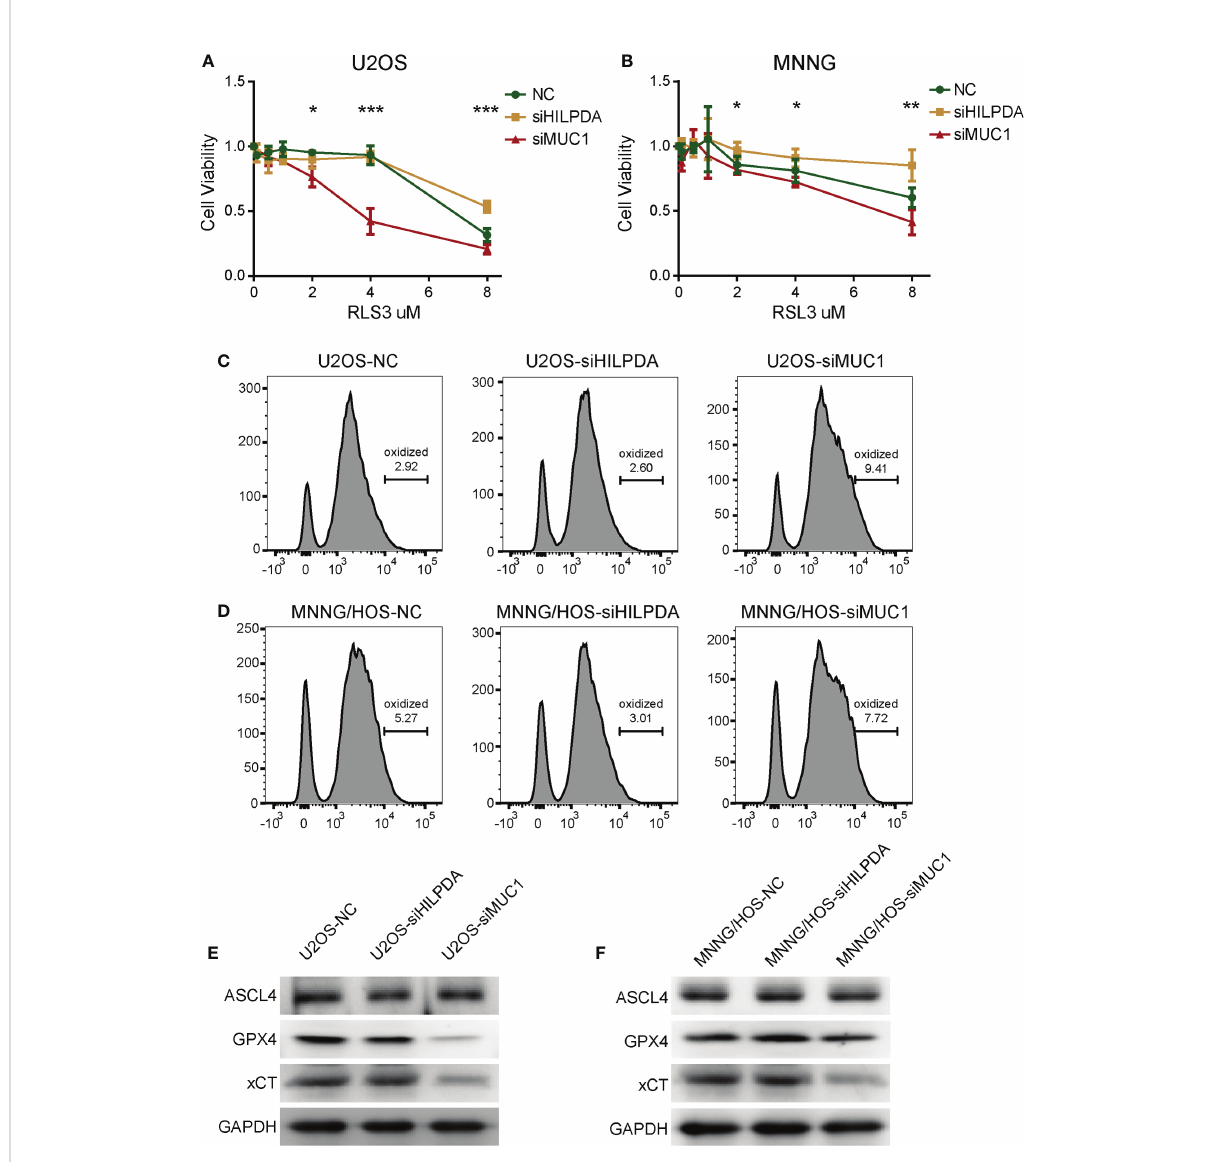
FIGURE 7 The effects HILPDA or MUC1 on ferroptosis resistance in OS cells. CCK-8 method detected the cell viability of U2OS (A) and MNNG/HOS (B) after treatment by different concerntrations of RSL3 for 24h. One-way Anova test * P < 0.05; ** P < 0.01; *** P < 0.001. Lipid ROS levels of RSL3 induced U2OS (C) and MNNG/HOS (D) after C11 BODIPY incubation based on fl ow cytometry. Levels of ferroptosis-related proteins including ASCL4, GPX4 and xCT in RSL3 induced U2OS (E) and MNNG/HOS (F)